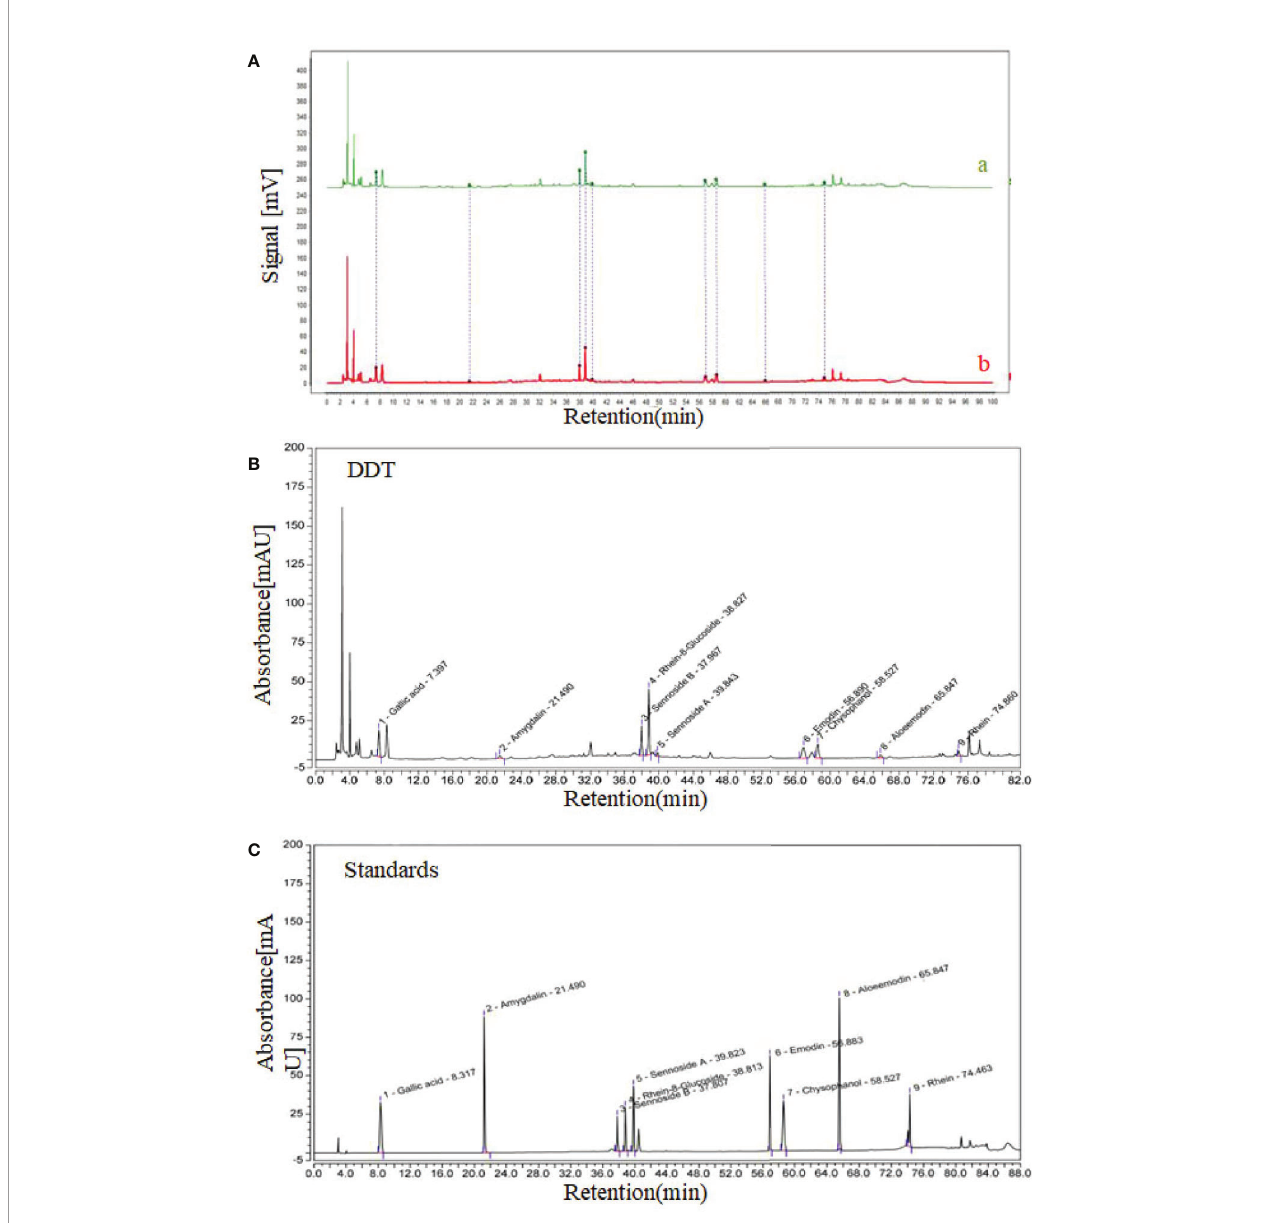
FIGURE 1 | High-performance liquid chromatography (HPLC) chromatogram of DiDang Tang (DDT). (A) HPLC chromatograms of DDT (b) and the control fi ngerprint chromatogram (a) using National Pharmacopeia Committee Chinese Medicine Fingerprint Similarity Evaluation System (2004A) Software are shown. (B) DDT levels were determined using HPLC. (C) Gallic acid, amygdalin, sennoside B, rhein-8-glucoside, sennoside A, emodin, chrysophanol, aloeemodin, and rhein were identi fi ed by